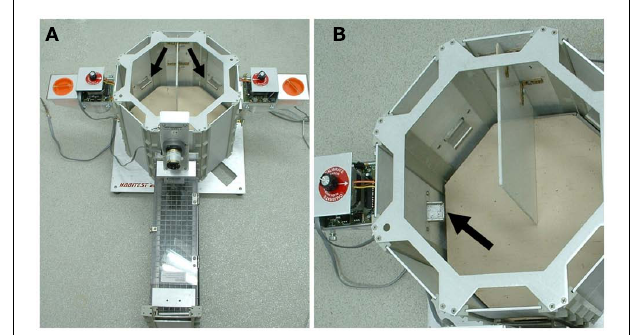
FIGURE 3 |The two-lever operant chamber model (RGT rewardprobabilities ). (A) Octagonal arena connected to a starting corridor. Levels are indicated by the arrows. (B) The arena is divided in two sides by a central separator, each containing one lever and one food cup (indicated by an arrow) connected to an automated pellet